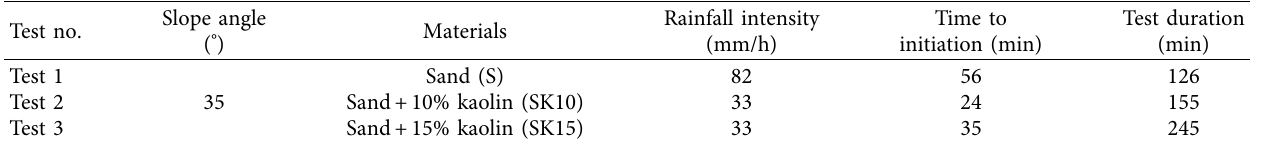
Figure 4: (a) Detail of the sprinkler branch with axial-fow full-cone nozzles; (b) simulated rainfall in Test 1 (blue), Test 2 (orange), and Test 3 (green). Table 2: Basic data of the performed